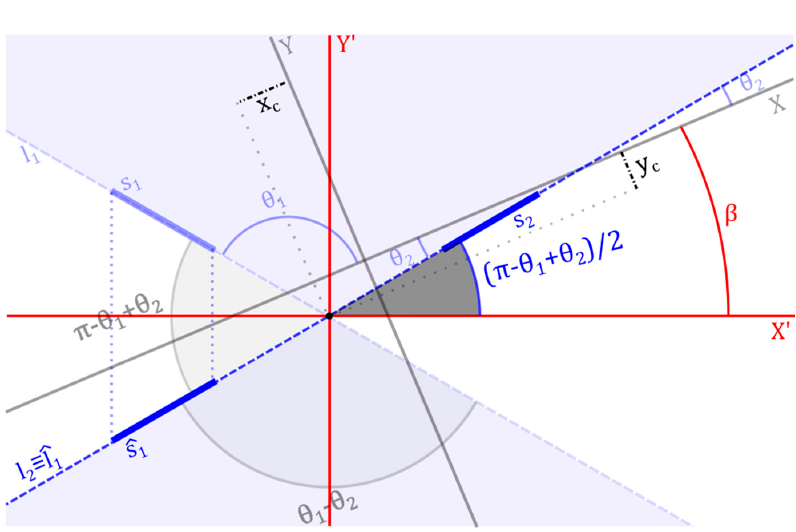
Figure 2. Cartesian coordinates system formed by bisectors centred at the intersection.